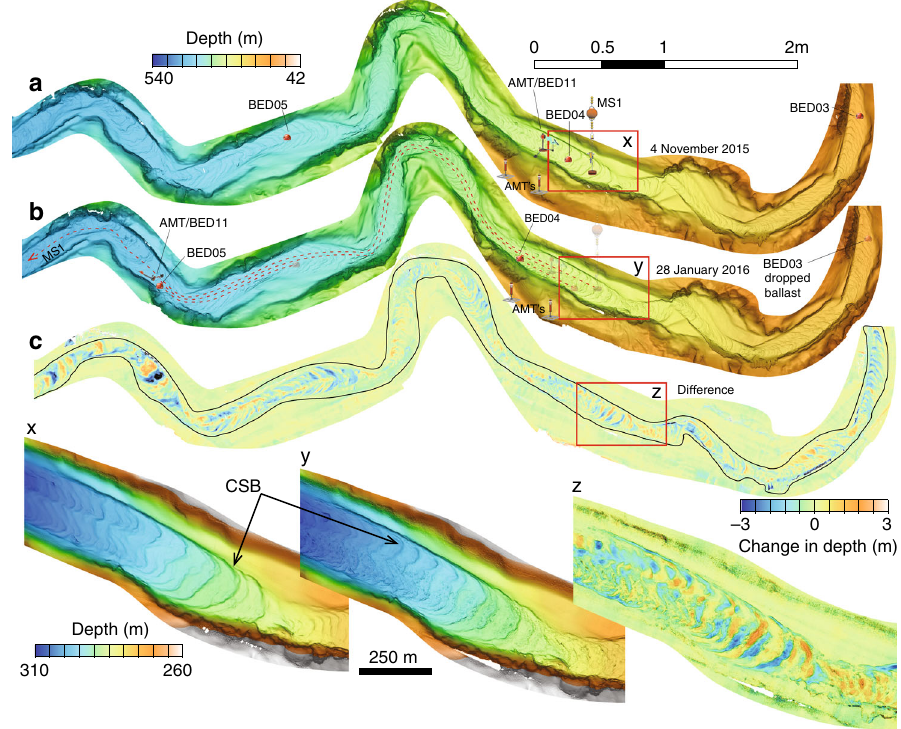
Fig. 5 Repeat mapping shows changes in canyon fl oor morphology. a Bathymetric maps for the upper canyon collected with an Autonomous underwater vehicle between 42 and 540 m water depths on 4 November 2015 and b on 28 January 2016 (Fig. 1). Initial and fi nal positions of instruments that moved on 15 January 2016 are also shown in a and b , respectively. c Changes in sea fl oor elevation between surveys a and b . x, y, and z are enlarged sections of a , b , and c , respectively. CSB Crescent-shaped